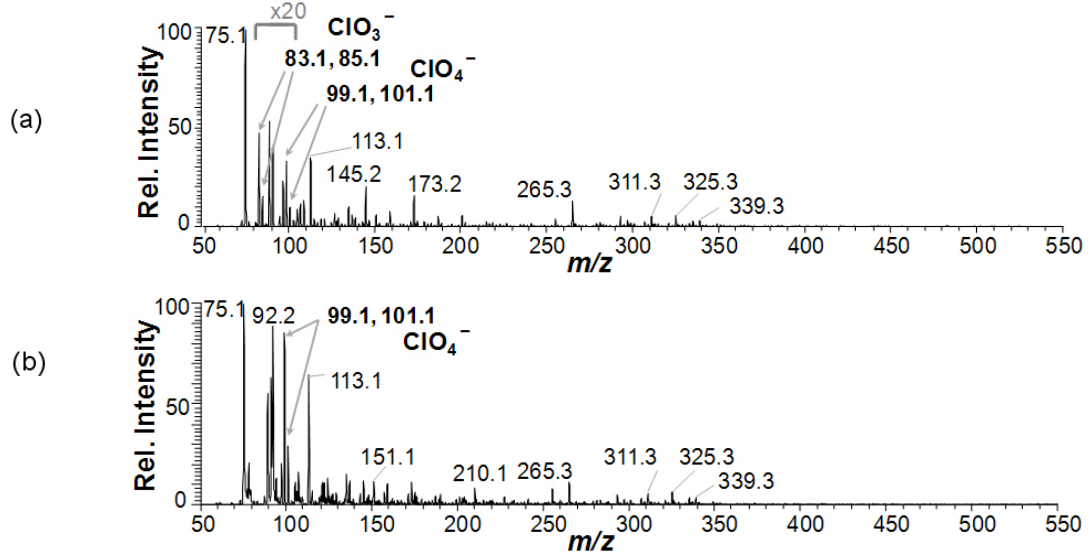
Figure 5. Negative ion DESI mass spectra of paper samples from commercial fireworks (a) spectrum obtained from analysis of paper tube containing combustive material (b) spectrum obtained from analysis of cover paper tube of firework (no background